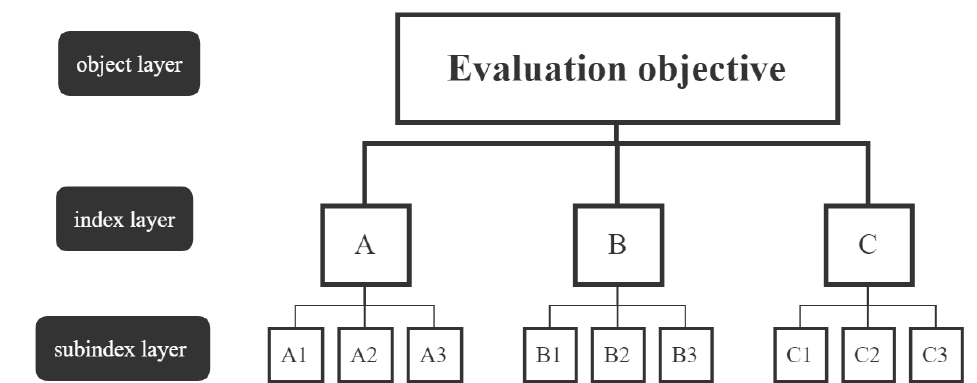
Figure 2. The structure diagram of the AHP hierarchical network.